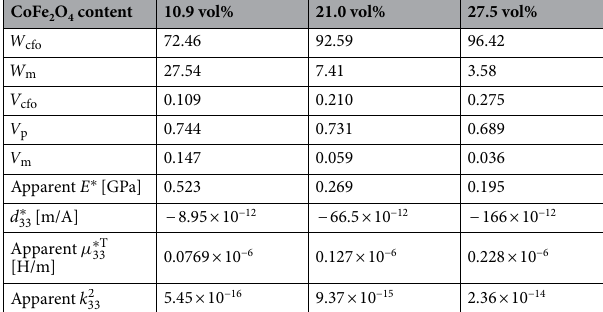
Table 1. Parametric values of the CNF–CoFe 2 O 4 composite papers.